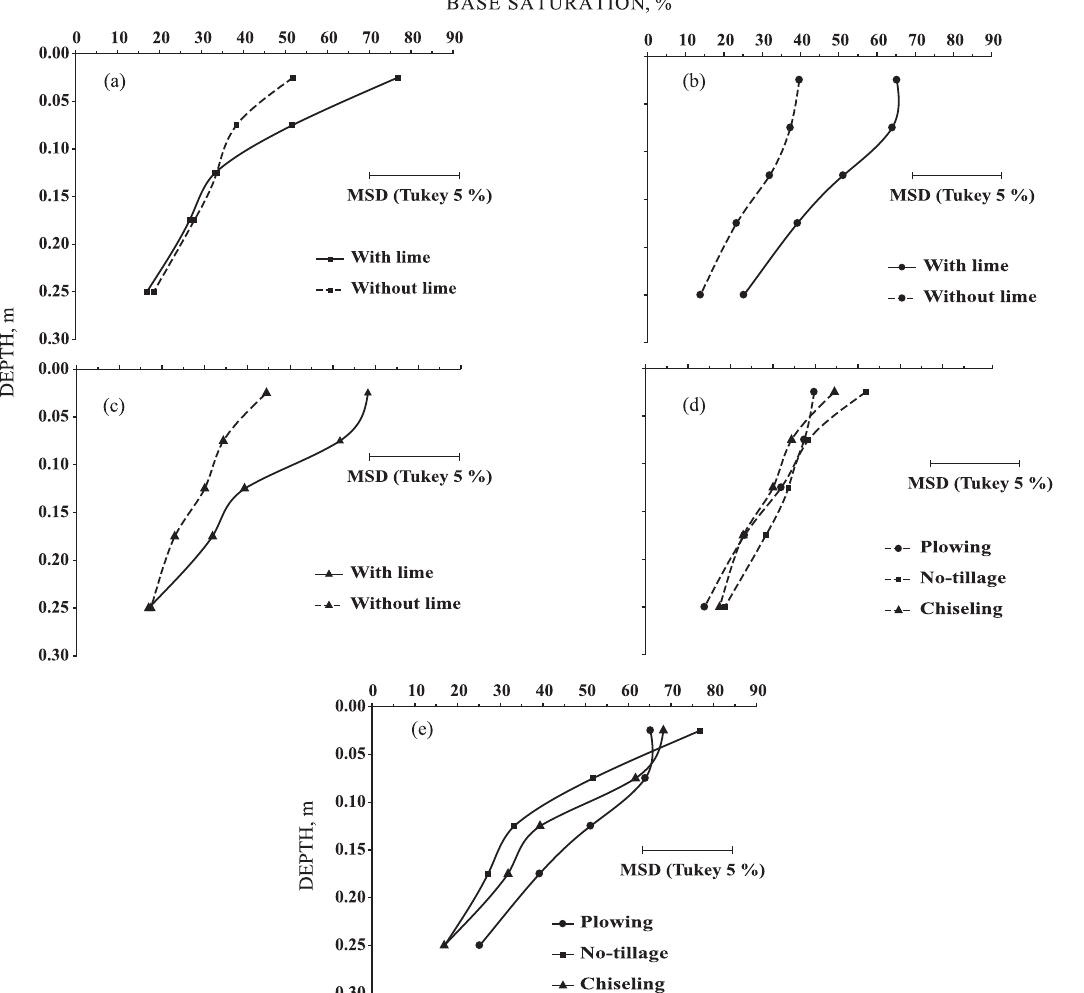
Figure 3. Values of base saturation in an Oxisol under the no-till system, submitted to the modes of tillage: no tillage (a), plowing (b), chiseling (c) and liming: without lime (d) and with lime (e). MSD (minimum significant